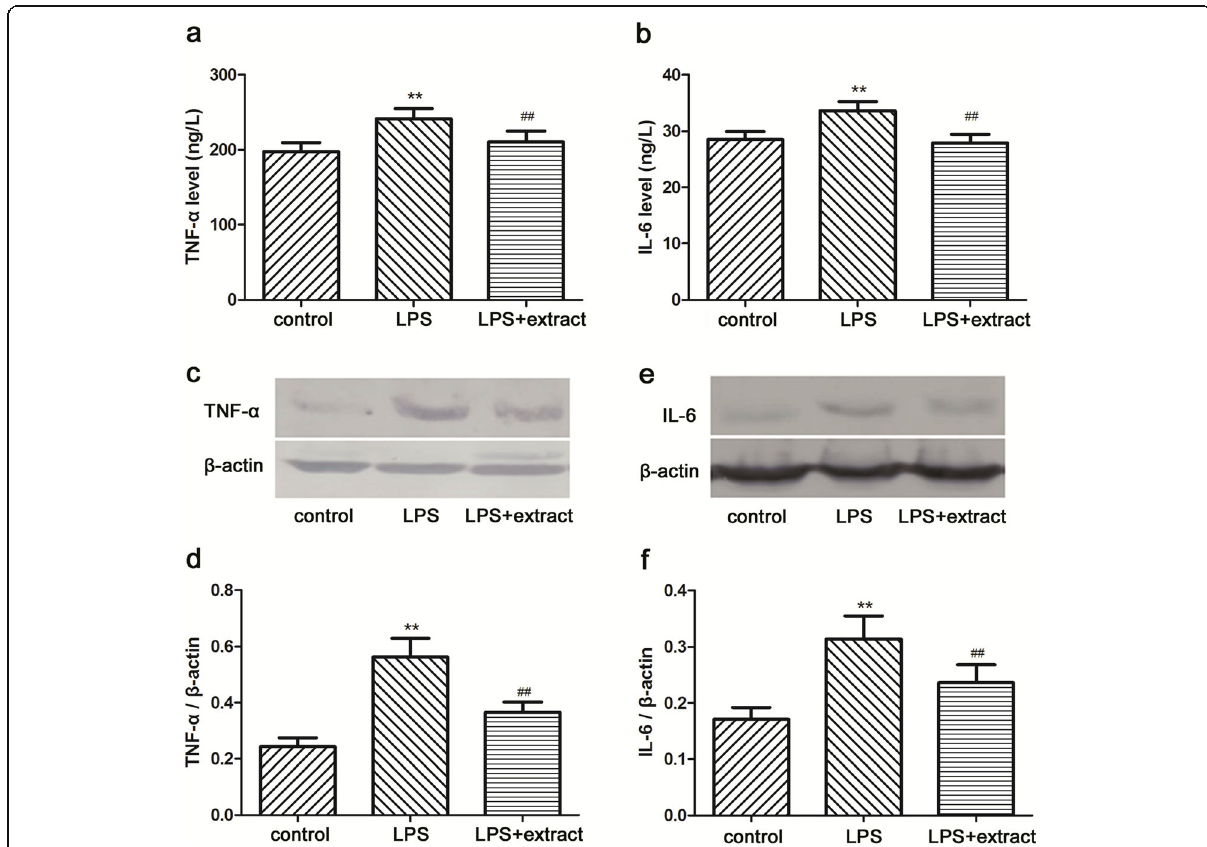
Fig. 3 Effect of the venom extract on inflammation. Seruml evels of TNF- α ( a ) and IL-6 ( b ) were determined by TNF- α , and IL-6 specific ELISA kit. Values were expressed as means ± SD ( n = 10). TNF- α ( c ) and IL-6 ( e ) in hearts were analyzed by western blot. Relative amounts of TNF- α ( d ) and IL-6 ( f ) were assessed by TNF- α and IL-6 to β -actin ratio ( n = 6), respectively. ** p < 0.01 vs. Control group; ## p < 0.01 vs. LPS group